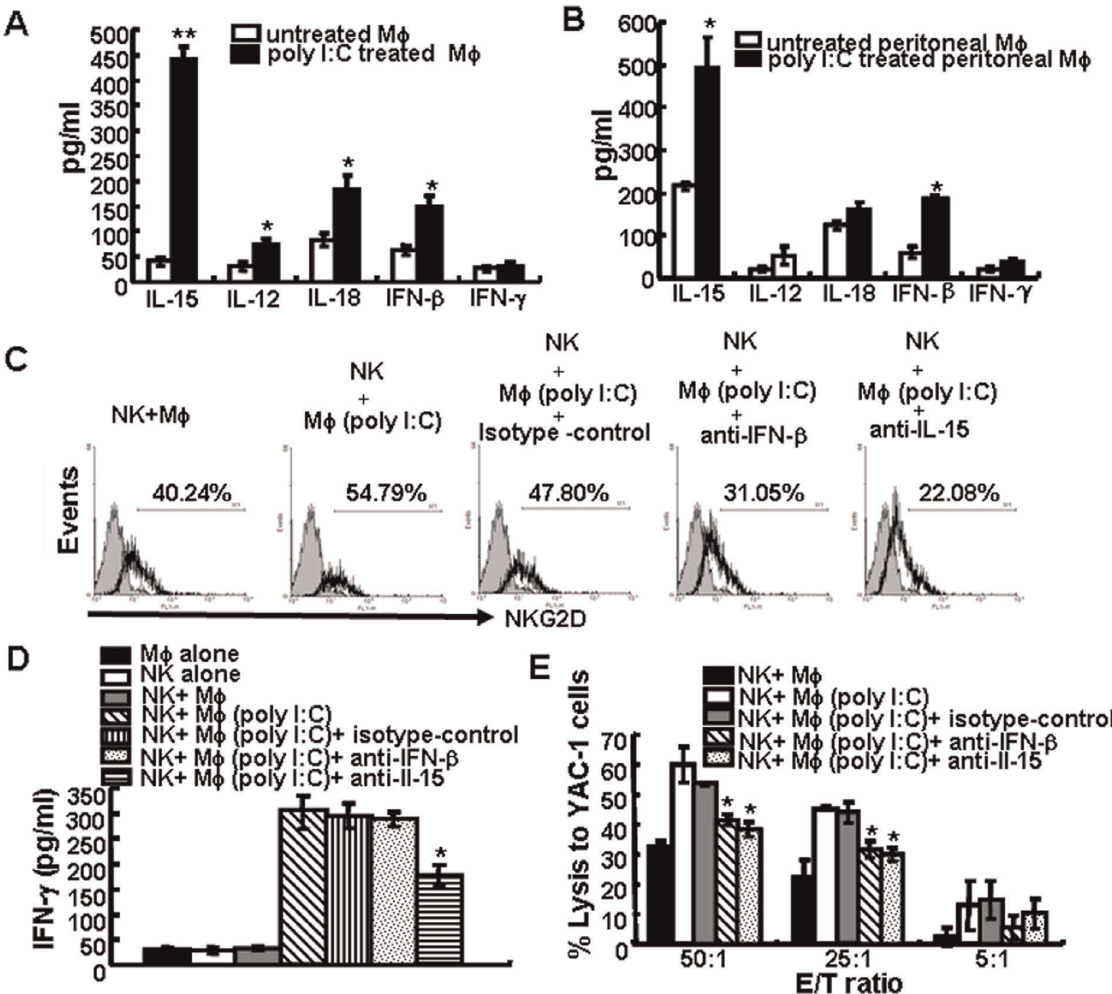
Figure 6. Cytokines secreted by poly I:C-treated macrophages play critical roles in NK cell activation. The secretion levels of IL-12, IL-15, IL-18, IFN- b , or IFN- c in the supernatants of RAW264.7 cells (A) or resident peritoneal macrophages from BALB/c mice (B) that were cultured with 0 or 100 m g/ml poly I:C for 24 h were analyzed by ELISA. The data are expressed as the mean 6 SD from at least three separate experiments. *p , 0.05, **p , 0.01 compared with the untreated RAW264.7 group. NK cells were incubated with poly I:C-pretreated RAW264.7 cells in the presence of 10 m g/ ml anti-IL-15 mAb, anti-IFN- b mAb or isotype control separately for another 12 h, and the expression of NKG2D were determined by flow cytometry (C). Levels of IFN- c in the supernatants were determined by ELISA (D). NK cell-mediated lysis of YAC-1 cells was assessed by first culturing NK cells with poly I:C-treated RAW264.7 cells (M w ) in the presence or absence of anti-IL-15 mAb, anti-IFN- b mAb or isotype control, respectively, and then NK cells were isolated and added to target cells (E). Data are expressed as the mean 6 SD from at least three separate experiments. *p , 0.05 compared with the isotype control group.